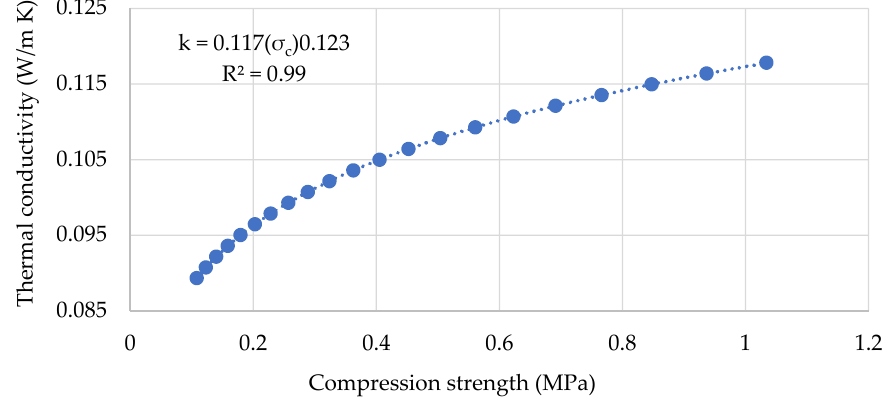
Figure 8. Thermal conductivity as a function of compressive strength.